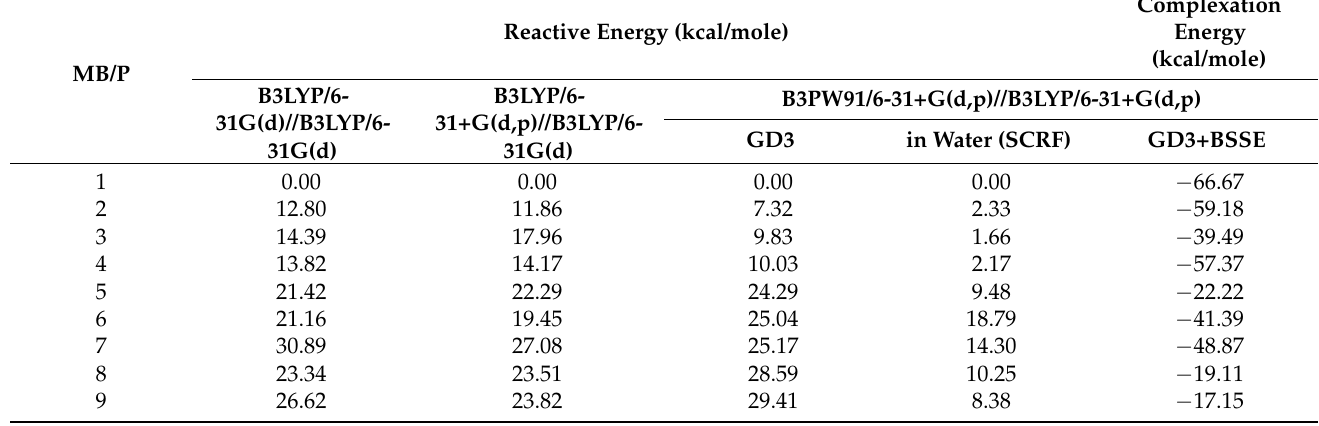
Table 1. The reactive energies and complexation energies of MB/pullulan (MB/P)